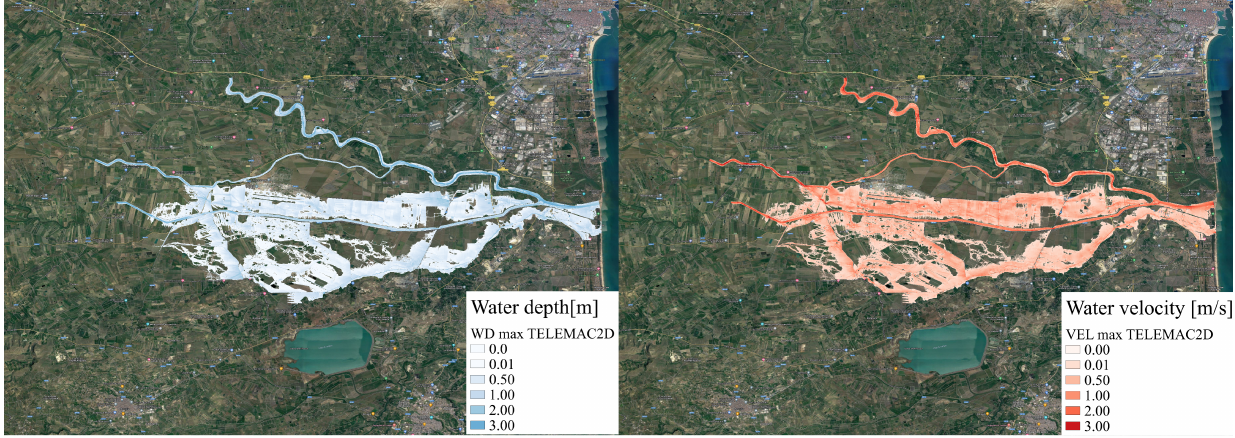
Figure 8. Results of TELEMAC-2D coupled with the Continuum; maximum water depth (on the left) and maximum water velocity (on the right) for the event that hit the Catanian floodplain 24–25 October